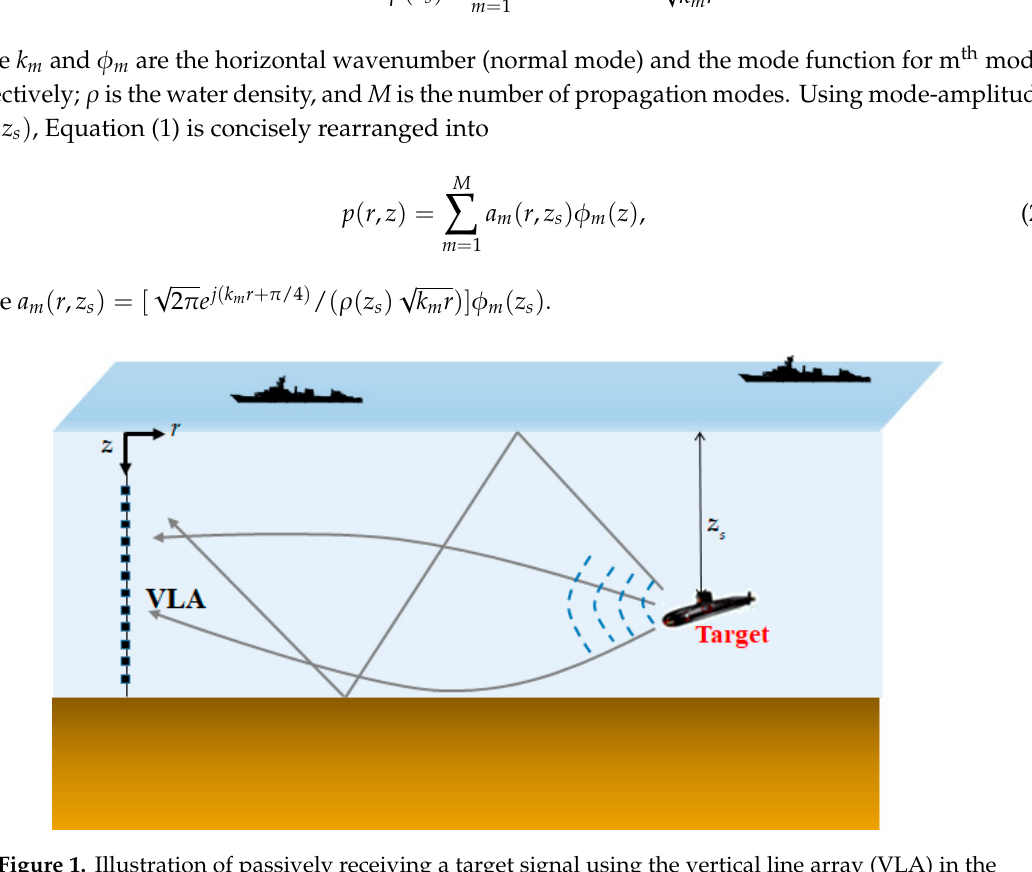
Figure 1. Illustration of passively receiving a target signal using the vertical line array (VLA) in the ocean